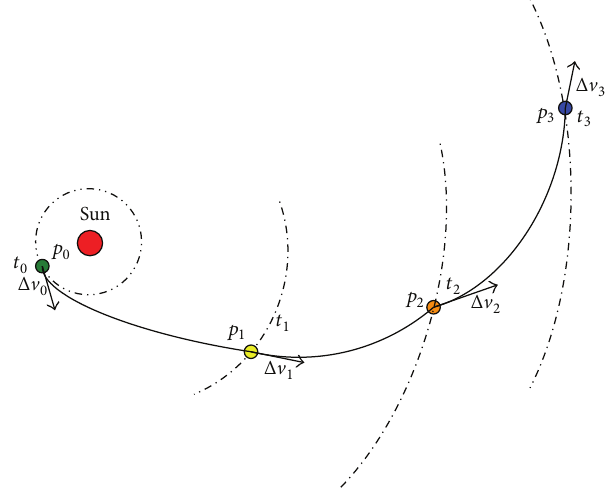
Figure 1: Multiple gravity assist